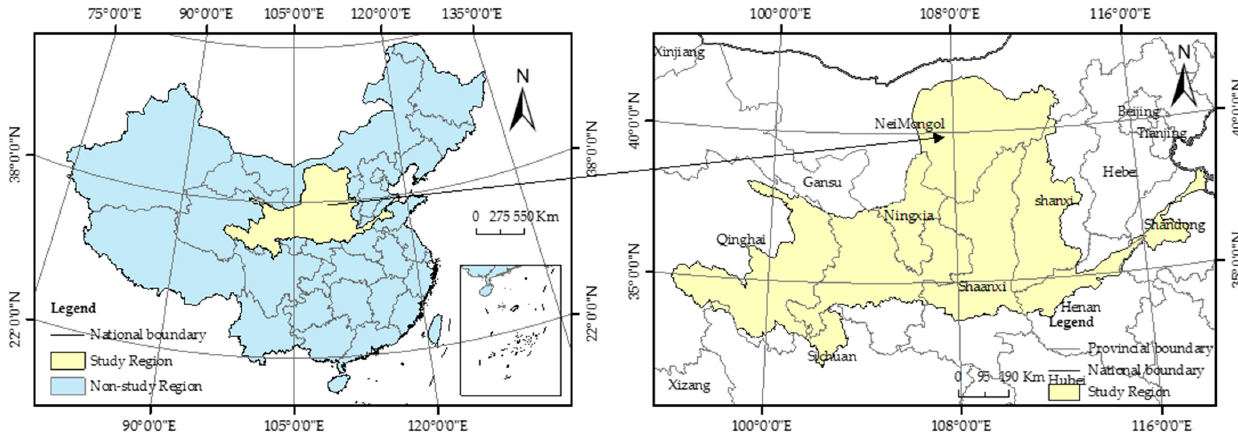
Figure 1. Location map of the Yellow River Basin.